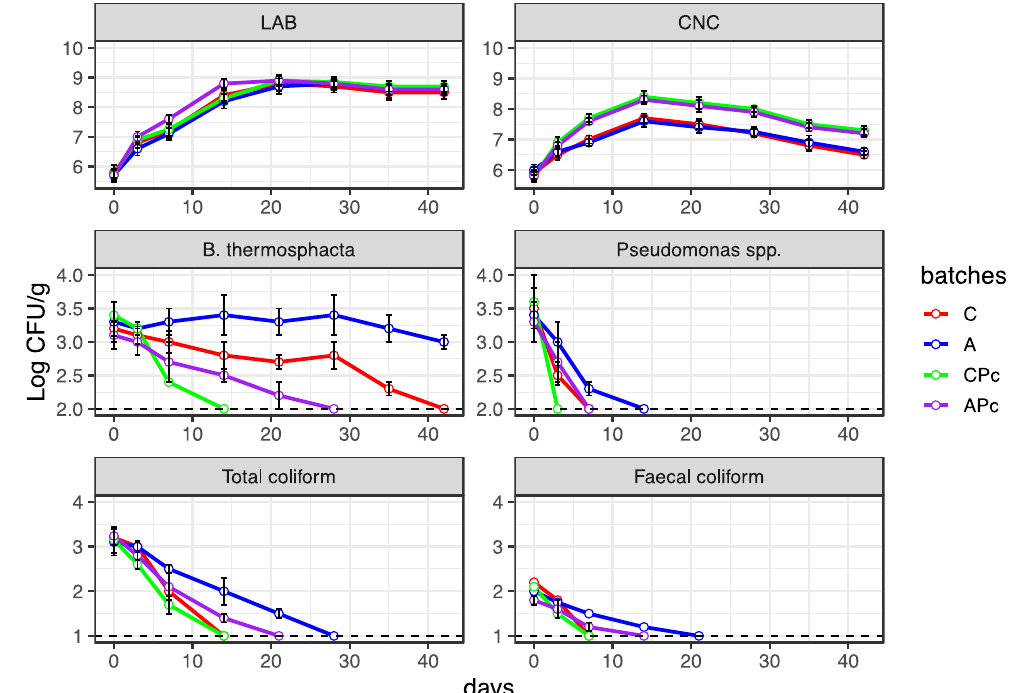
Figure 5. Line plots showing the behaviours of the main microbial groups in samples from batch C, 398 conventional fermented sausage prepared with starter culture and 14% minced pork fat additions; 399 batch A, prepared with 4% lemon albedo in total replacement of pork fat and starter culture addition; 400 batch CPc, prepared with starter culture and 14% minced pork addition plus anti- Listeria 401 Lactiplantibacillus plantarum Lpls100; batch APc, prepared with 4% lemon albedo in total replacement of 402 pork fat and starter culture addition plus anti- Listeria Lactiplantibacillus plantarum Lpls100. The data 403 are reported as the mean value with error bars. The dashed lines represent the limit of detection of 404 the microbial groups. 405